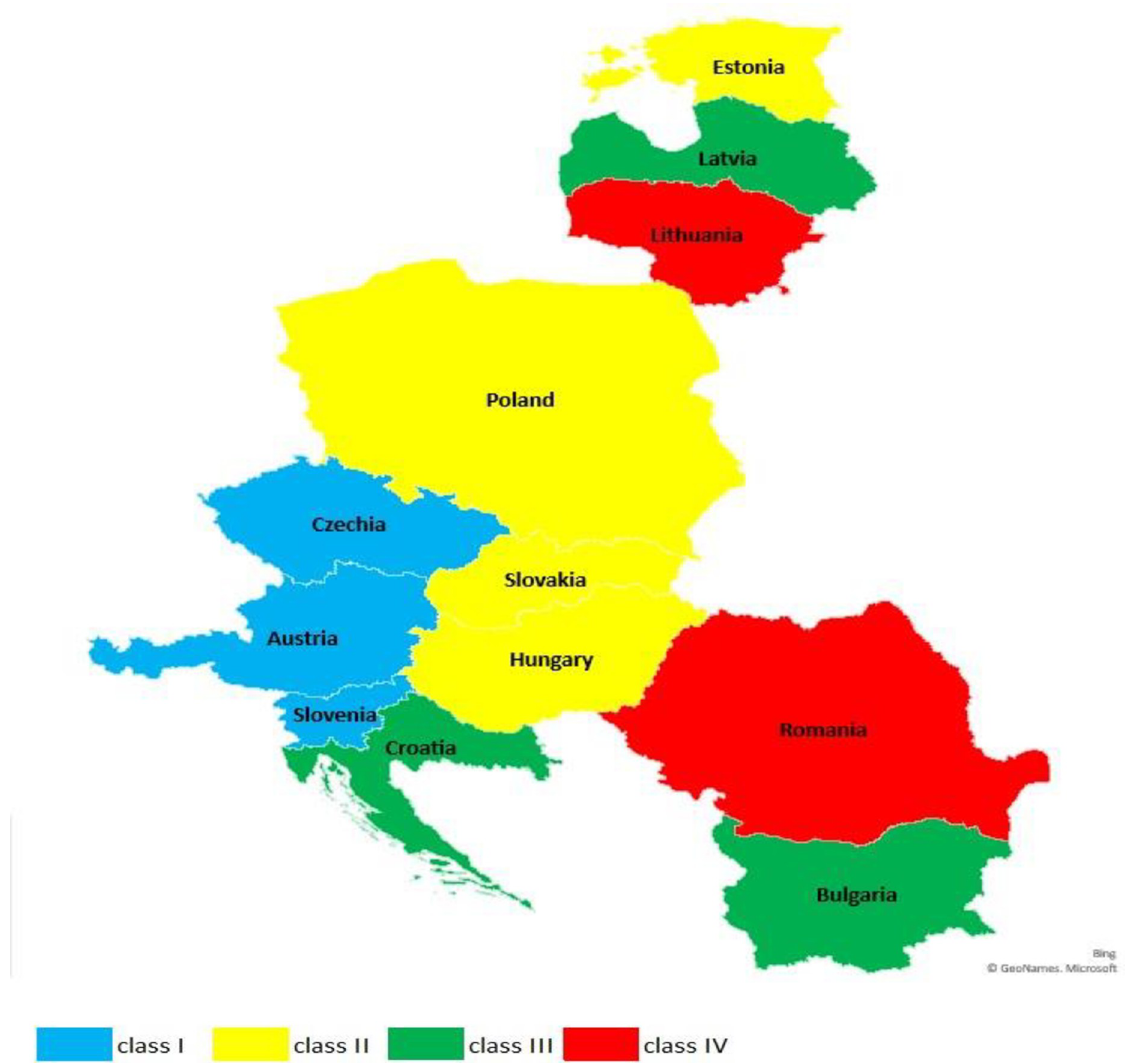
Fig 2. Spatial diversification of 3SI countries in terms of relative economic anchor level in